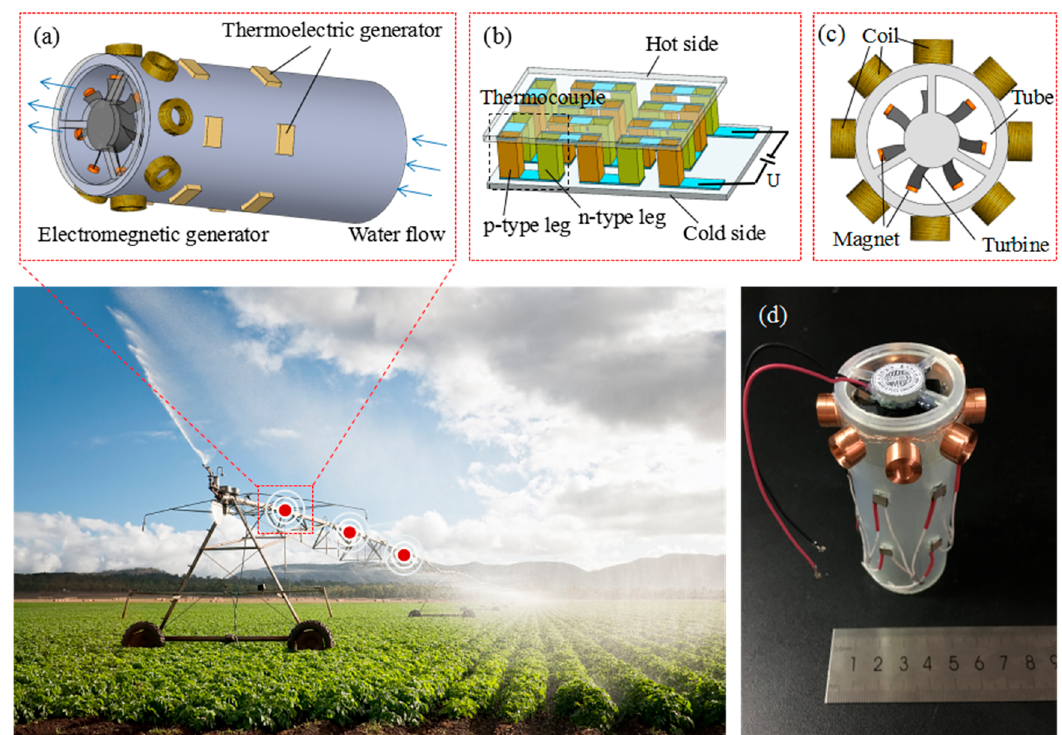
Figure 1. Diagram of hybrid energy harvester in irrigating pipe ( a ) Schematic diagram of hybrid energy harvester; ( b ) Three-dimensional (3-D) structure of thermoelectric generator (TEG); ( c ) Structural diagram of electromagnetic generator (EMG); and, ( d ) Photo of hybrid energy harvester.